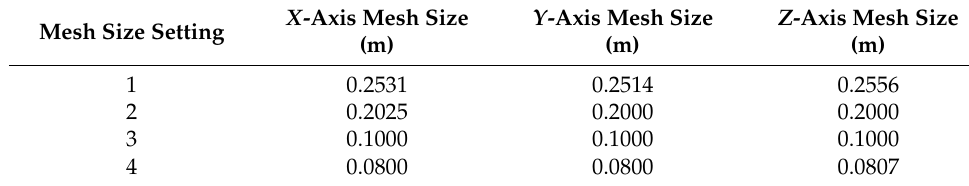
Figure 4. Arrangement of the thermocouple trees. Table 3. Mesh size setting options.